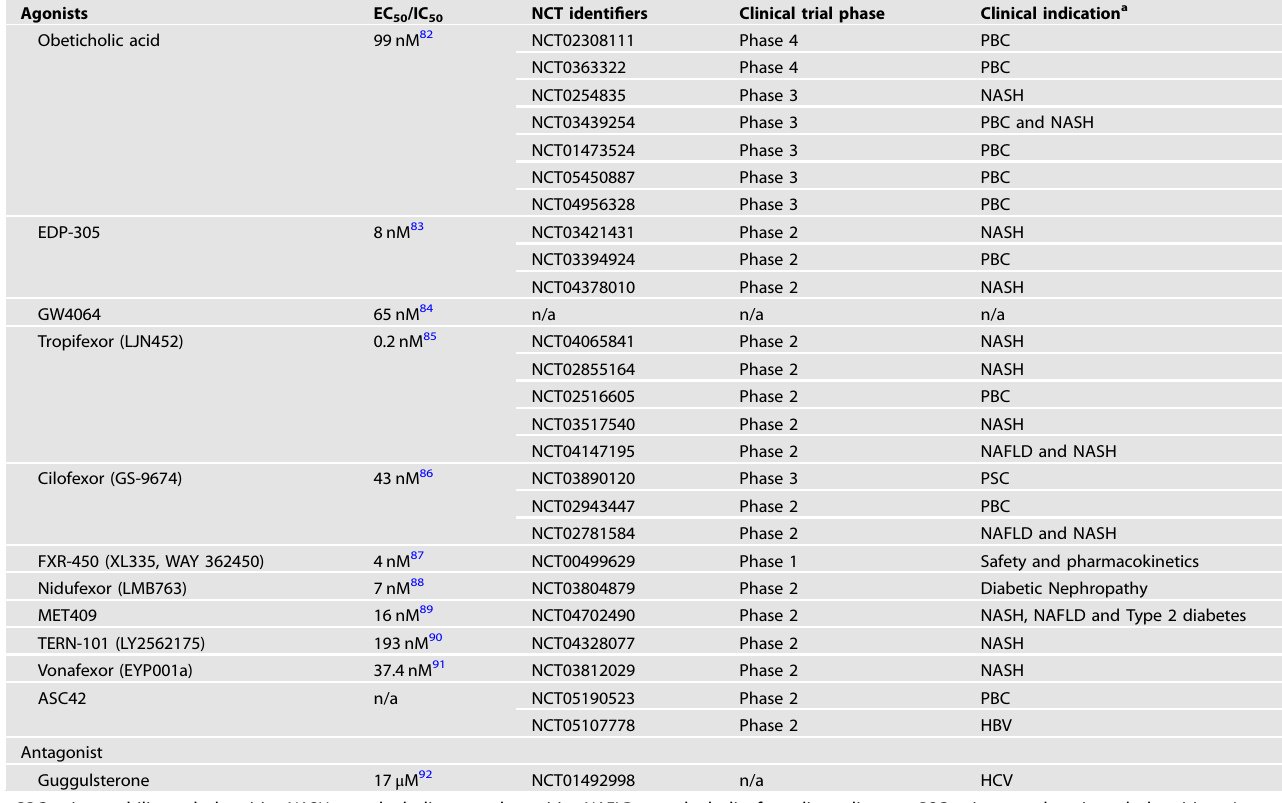
Table 2. Summary of the FXR modulating compounds in clinical